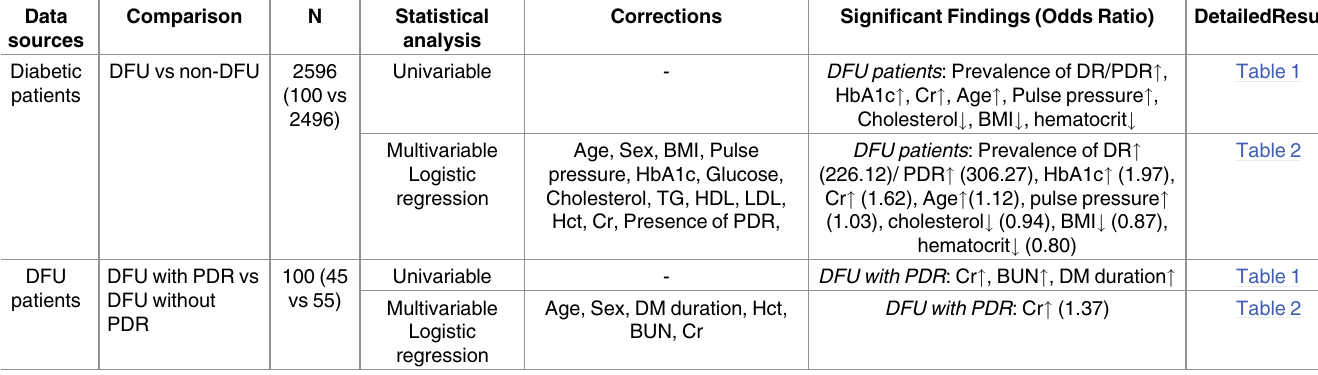
Table 3. Summaryof the results of the present